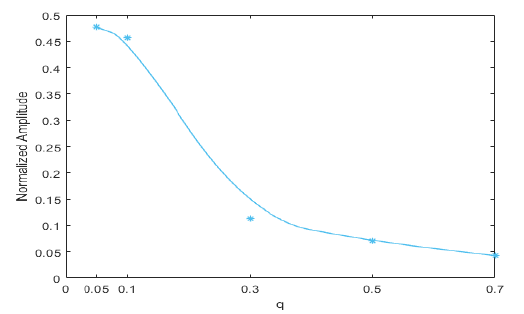
Figure 9. Variation trend of the second harmonic amplitude with crack